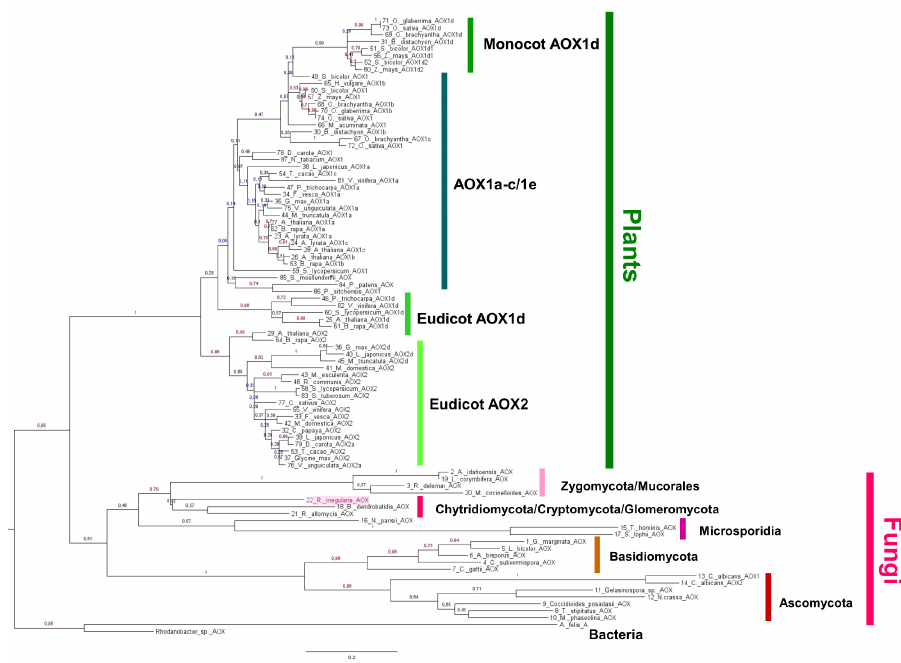
Fig 3. Maximum likelihood phylogenetic analysis of AOX protein sequences in fungi and plants. Two bacterial AOX sequences were placed as outgroup ( Rhodanobacter sp. and Afipia felis ). Location of R . irregularis is shaded. Fungal and plant AOX protein sequences were clearly separated by a ML bootstrap value of 0.95. The fungal sequences were grouped on two major clades, supported by a ML bootstrap value of 0.61: the Basidiomycota/Ascomycota clade, and a clade containing the Chytridiomycota, Cryptomycota, Glomeromycota, Microsporidia and Zygomycota phyla. Basidiomycota were separated from Ascomycota by a ML bootstrap of